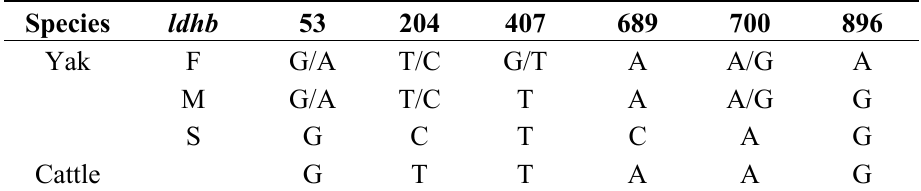
Table 1. Nucleotide position differences in ldhb alleles of Jiulong yak.